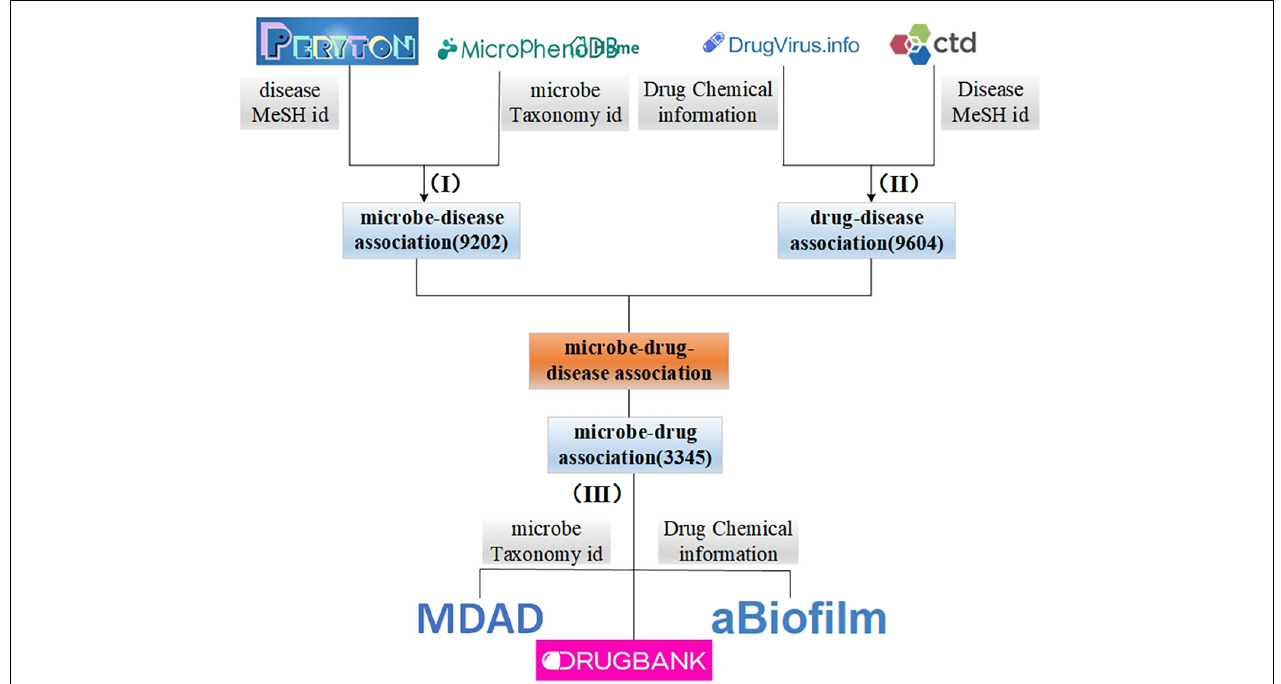
FIGURE 1 | The processing and integration process of microbe-drug-disease association data.